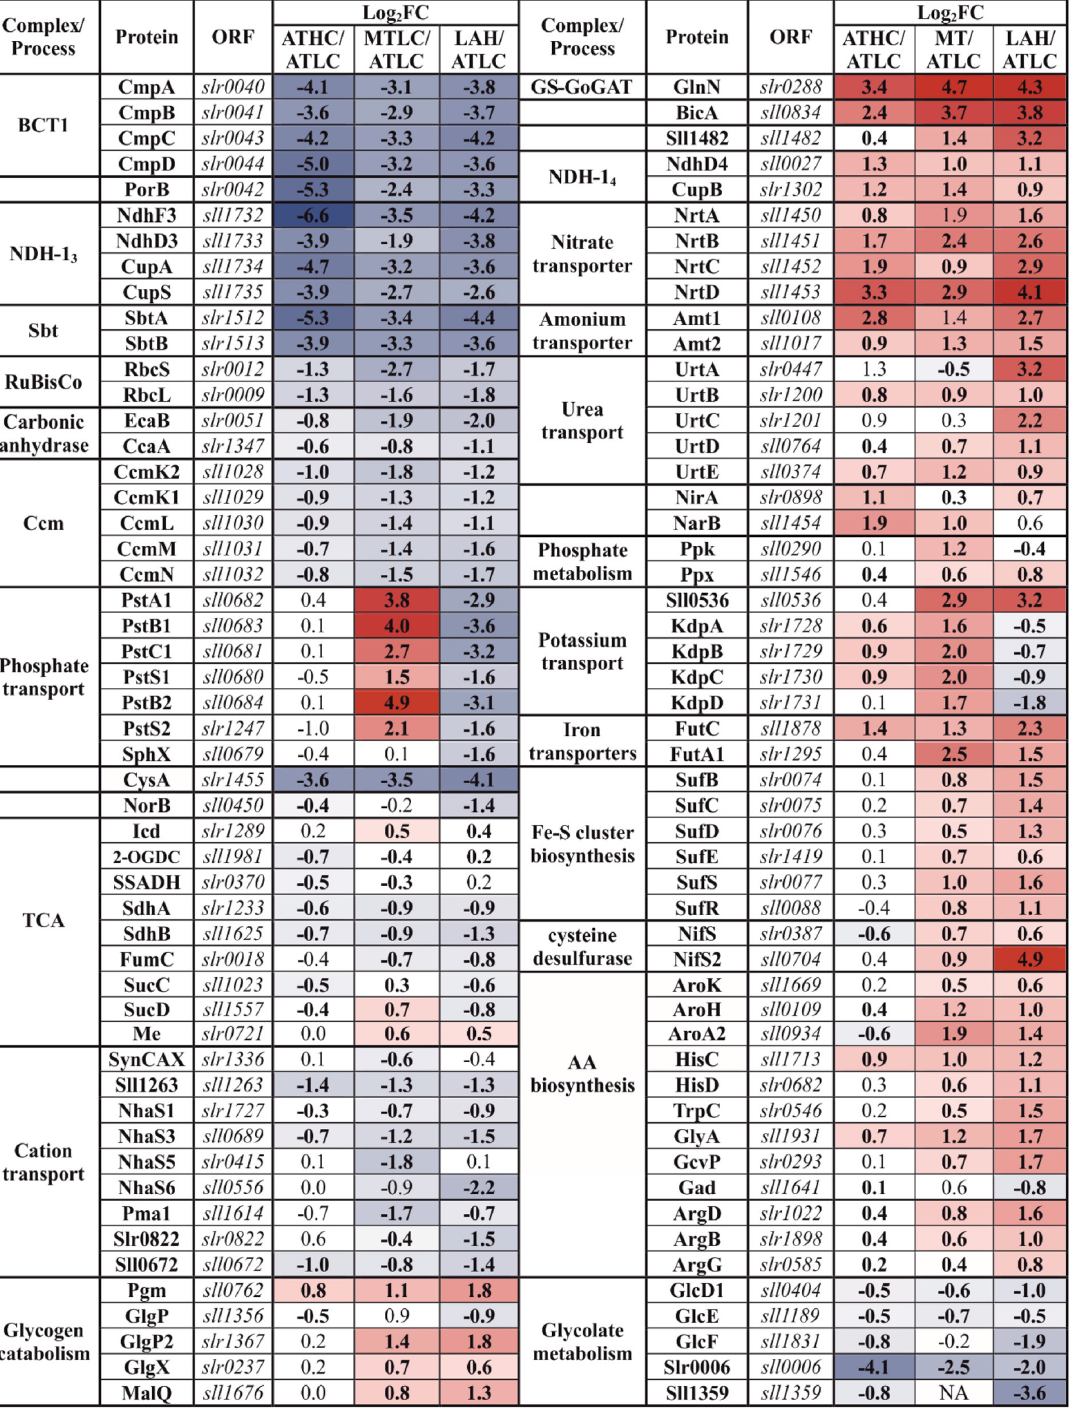
TABLE 2 | Differentially expressed proteins from the carbon metabolism (CBM)